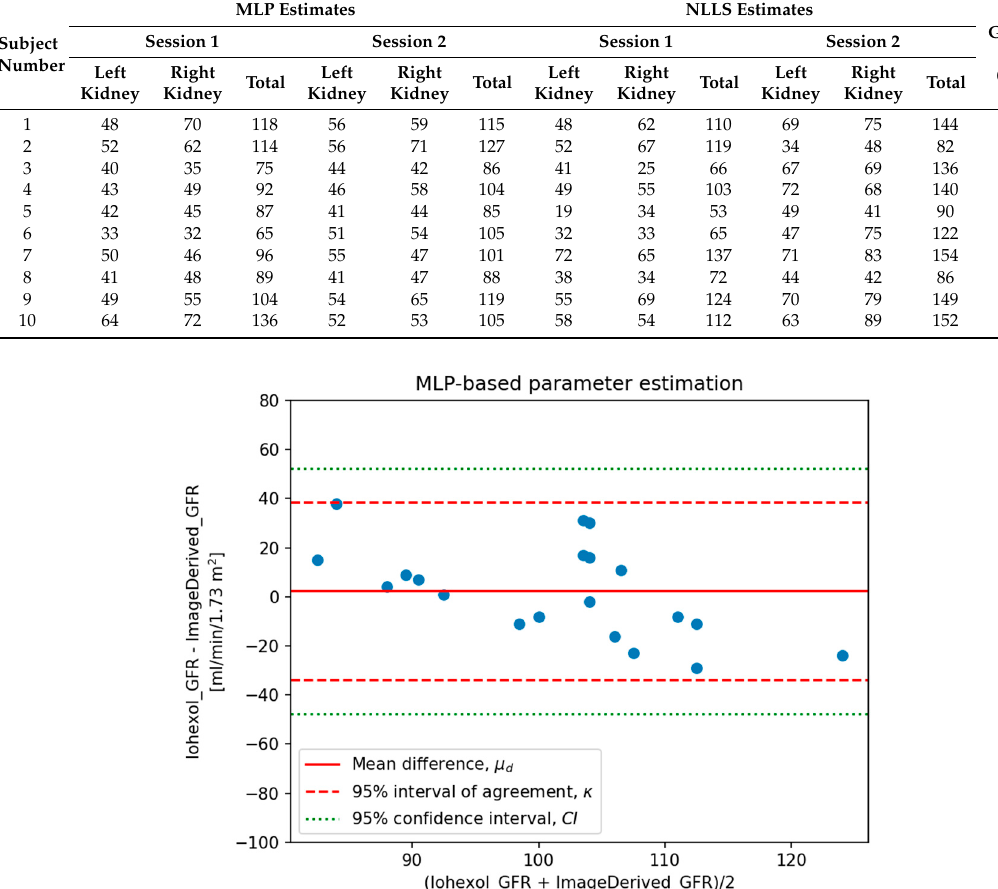
Table 4. Juxtaposition of GFR values estimated by MLP and NLLS methods based on DCE-MRI data acquired in two examination sessions in comparison with ground-truth scores measured with iohexol clearance test [ml / min / 1.73 m 2 ].